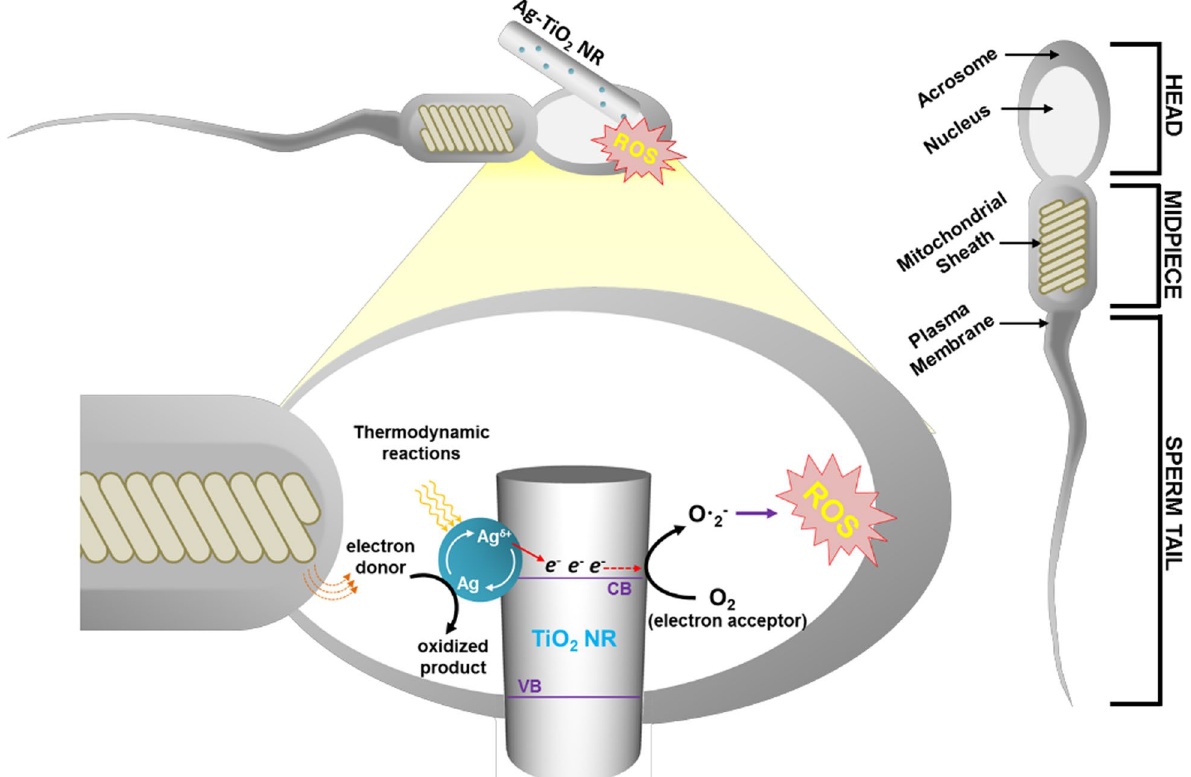
Fig. 8 Schematic representation of electron transfer mechanism in boar spermatozoa incubated with Ag‑loaded TiO 2 NR